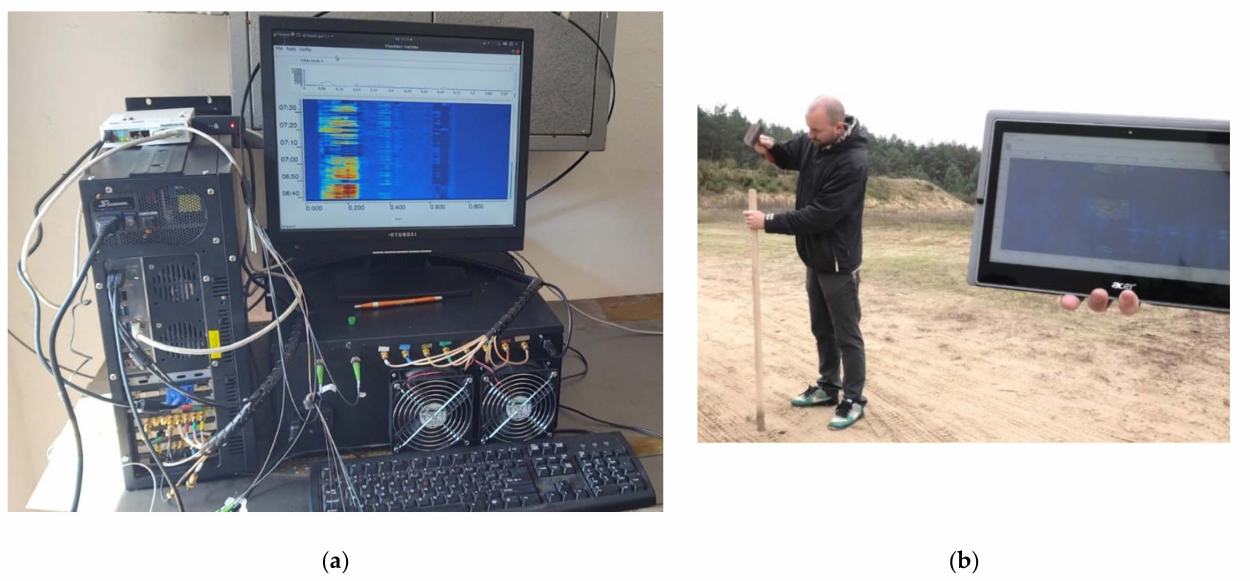
Figure 26. Two-fiber system testing under real conditions: ( a ) the sensing unit; ( b ) the generation of vibrations and the measurement remote